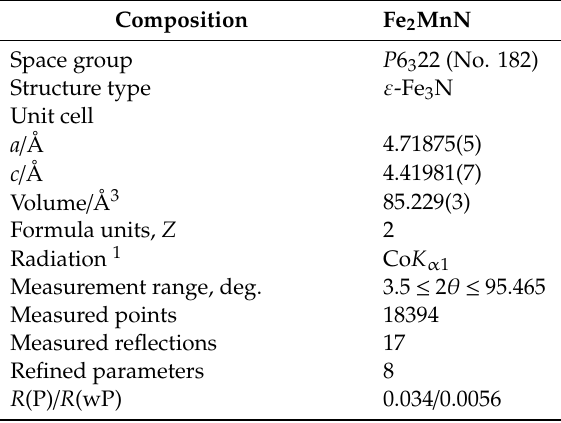
Table 2. Wycko ff positions, site occupancy factors (SOF), relative atomic coordinates and isotropic displacement parameters B iso (in 10 4 pm 2